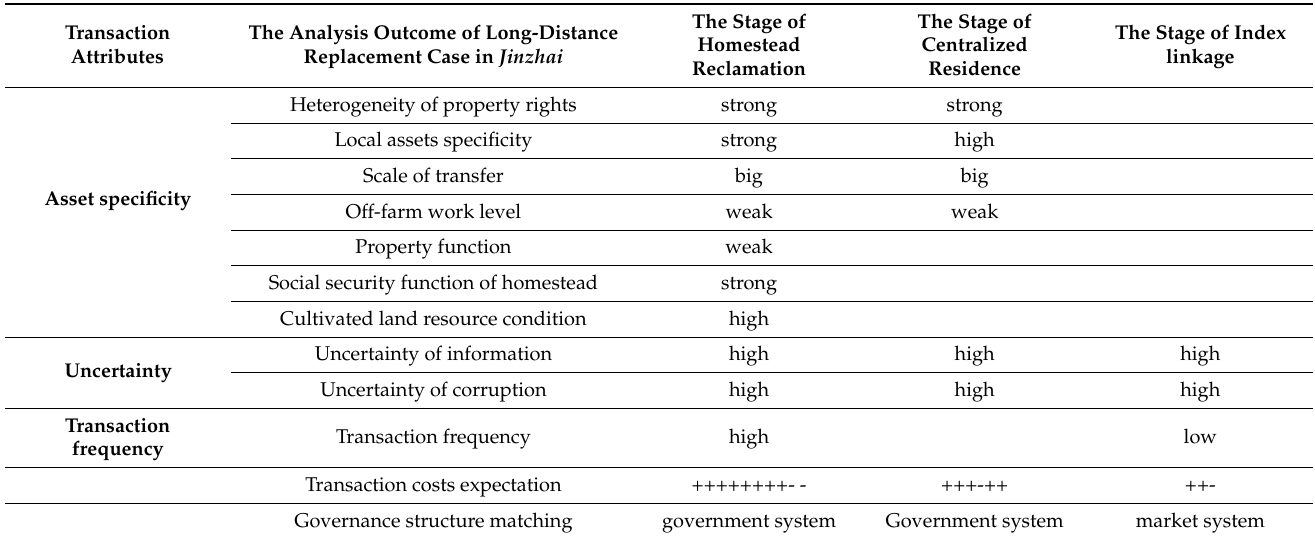
Table A5. The transaction attributes and the appropriate governance structures in Jinzhai